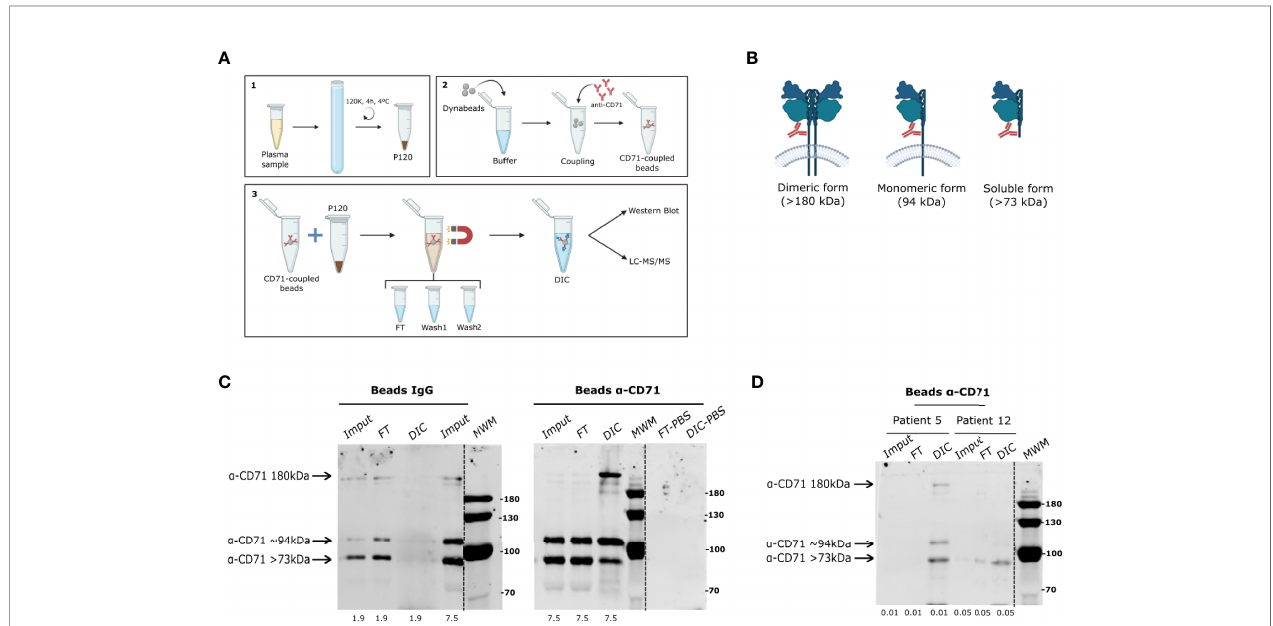
FIGURE 1 | CD71 direct immuno-af fi nity capture (DIC). (A) Chart showing an overview of the direct immune-capture (DIC) procedure. 1. Generation of total EVs (P120 fraction) by ultracentrifugation. 2. Coupling of monoclonal anti-CD71 antibody to commercial dynabeads. 3. Direct immune-capture of CD71 + EVs from total plasma EVs indicating downstream analysis by western blot and LC-MS/MS. (B) Representation of oligomeric (membrane bound) and cleaved (soluble) CD71 forms with their respective molecular weights indicating the region of the epitope to which monoclonal anti-CD71 antibody binds. (C) Western blot analysis of exosomes immune-captured from culture supernatant of human reticulocytes isolated from cord blood using anti-CD71 dynabeads. Left panel shows absence of CD71 forms in the DIC fraction of the speci fi city control condition (rabbit IgG isotype-dynabeads). Right panel shows CD71 forms enriched in the DIC fraction of anti-CD71 dynabeads as compared to equivalent protein amount loaded from the input (µg). (D) Western blot analysis of CD71 + EVs immune-captured from total EVs (P120) of two P. vivax patients using anti-CD71-dynabeads showing enrichment of all forms of CD71 in patient 5 and only 73 kDa in patient 12. Dashed lines in the blots indicate a non-adjacent well from the same membrane incubated with anti-CD71 antibody. Protein amount loaded on the gels is shown at the bottom. MWM, molecular weight marker in